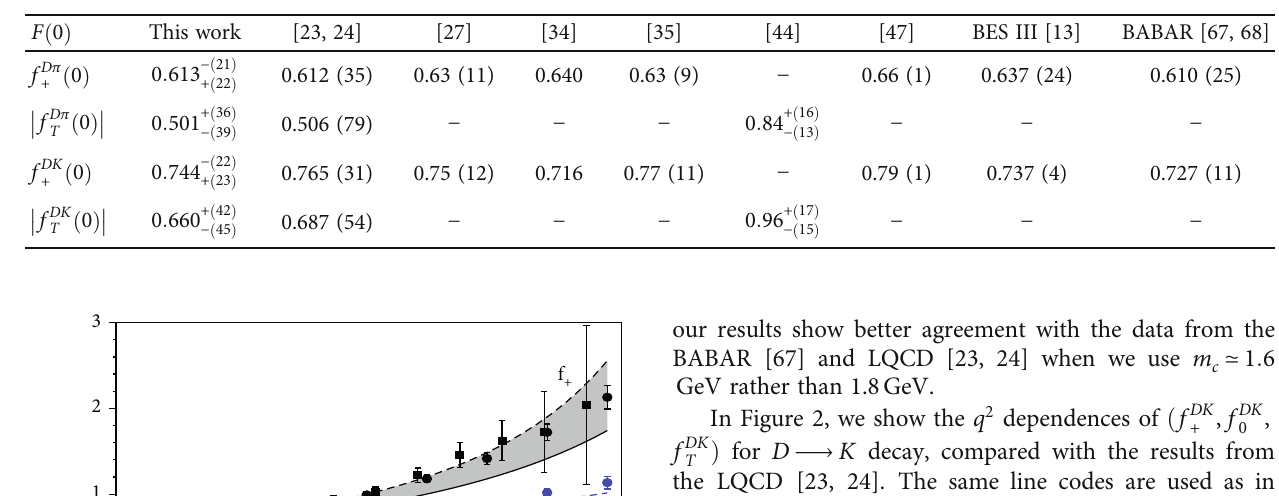
0 Þ and j f ð 0 Þj for D ⟶ ð π , K Þ transitions at q 2 = 0 compared with various model predictions and experimental + ð T